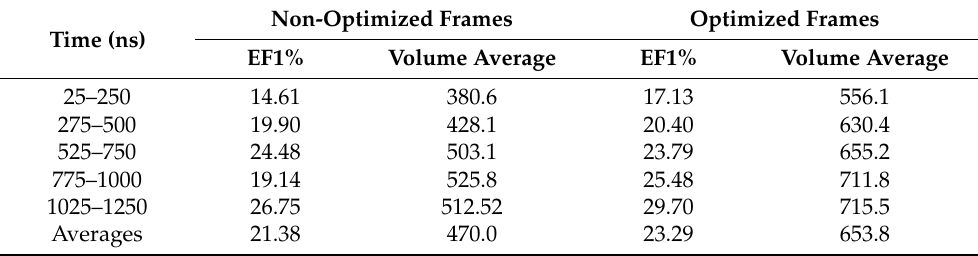
Table 5. Average values for the EF1% metrics and volumes of the binding pockets for optimized and non-optimized frames as computed by subdividing the MD run into five segments of 250 ns (the volume averages are expressed in Å 3 ).